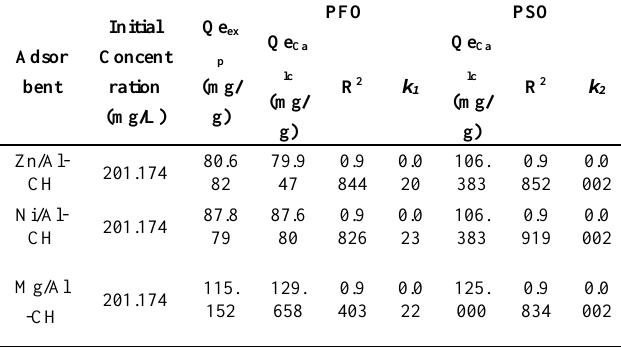
Figure 6. Time variation of adsorption Table 1. Kinetic parameter